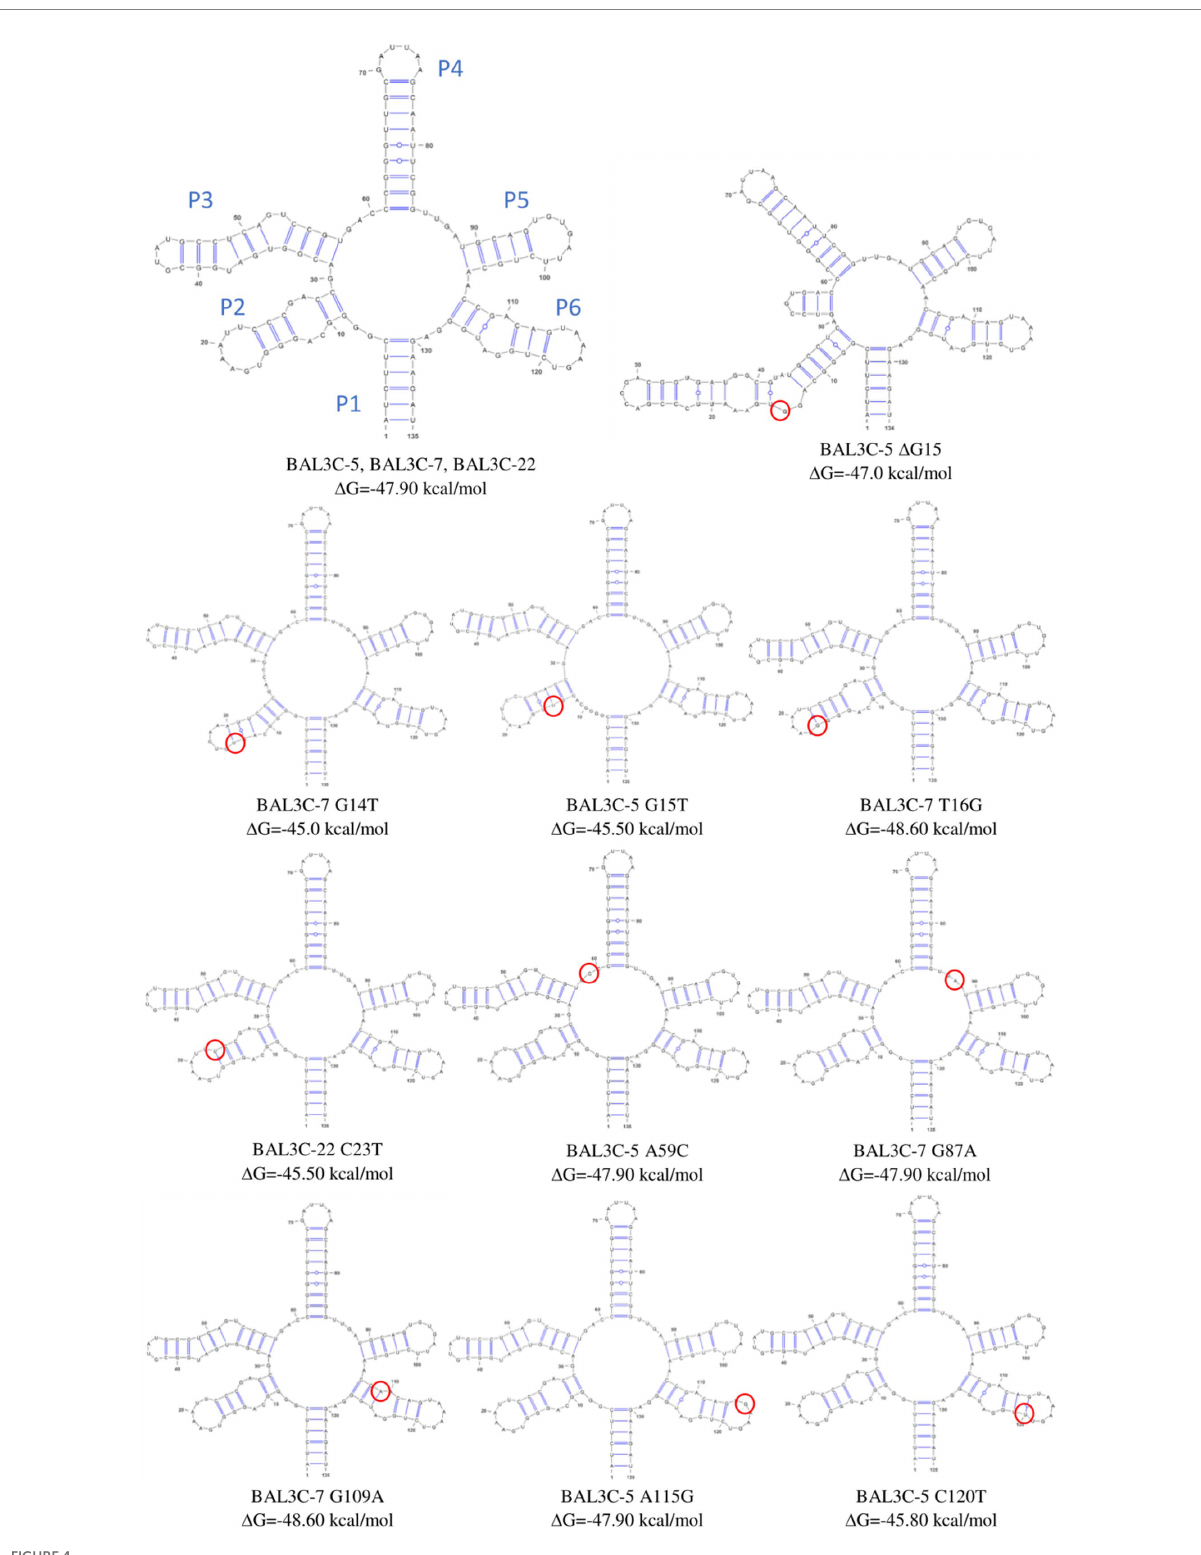
FIGURE 4 Predictive folding of the FMN riboswitch aptamer of the parental and of all the detected mutant strains. Change in Gibbs free energy ( Δ G) for each secondary structure and location of each mutation (red circle) are also